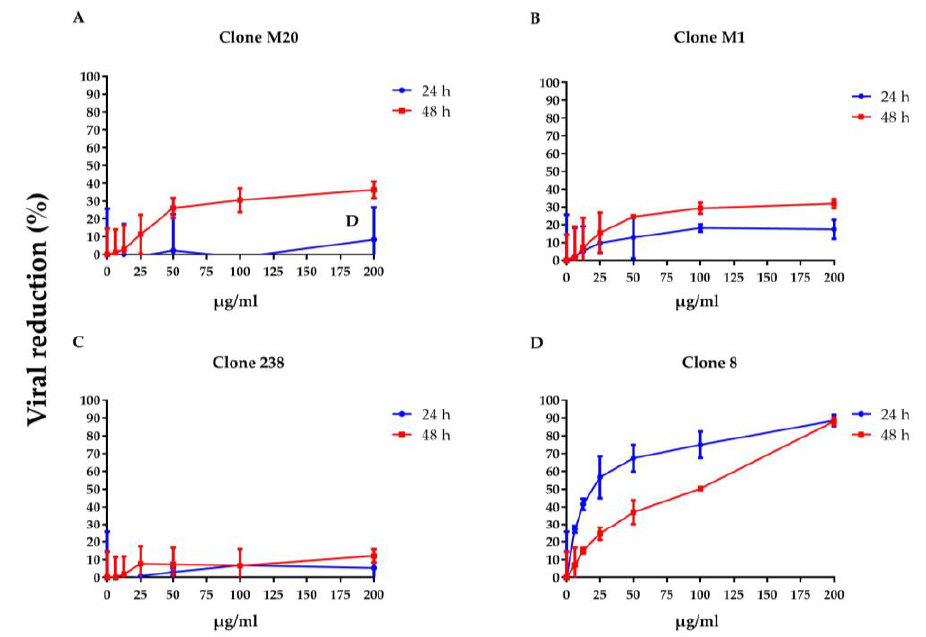
Figure 2. Anti-DENV NS1 HuMAbs induce ZIKV neutralization in endothelial cells: HUVECs are infected with ZIKV (MOI = 0.125) at 24 and 48 h post-infection. To determine the neutralization potency represented by the percentage of viral reduction in Vero cells, culture supernatants from four HuMAbs against DENV NS1 ( A ) M20; ( B ) M1; ( C ) 238 and ( D ) 8-treated infected cells are collected. The results are presented as the mean ± SD of duplicate independent experiments.